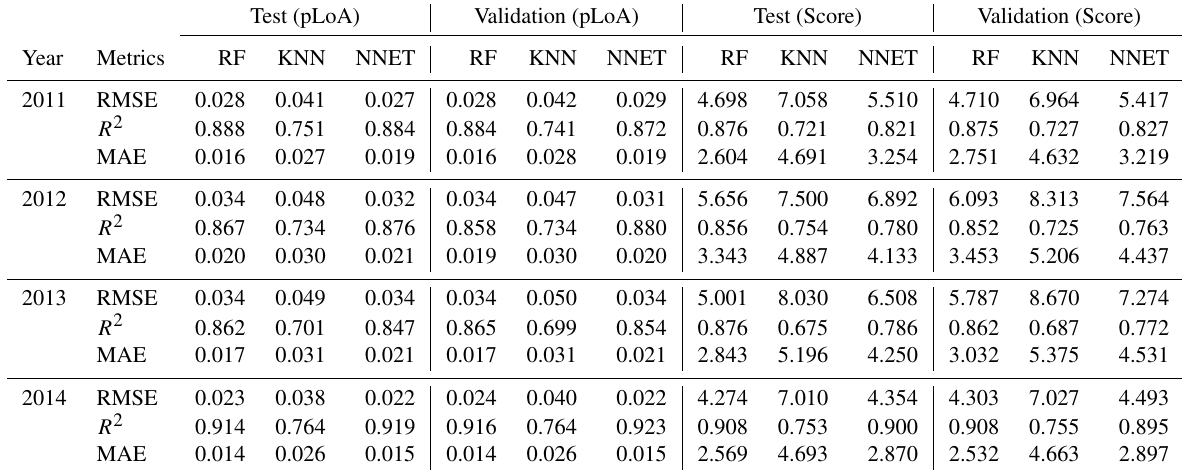
Table 3. Evaluation results of the predicted target variables, i.e. pLoA (in fraction) and Score, through comparison against values estimated using the MC simulation for the test and validation samples.